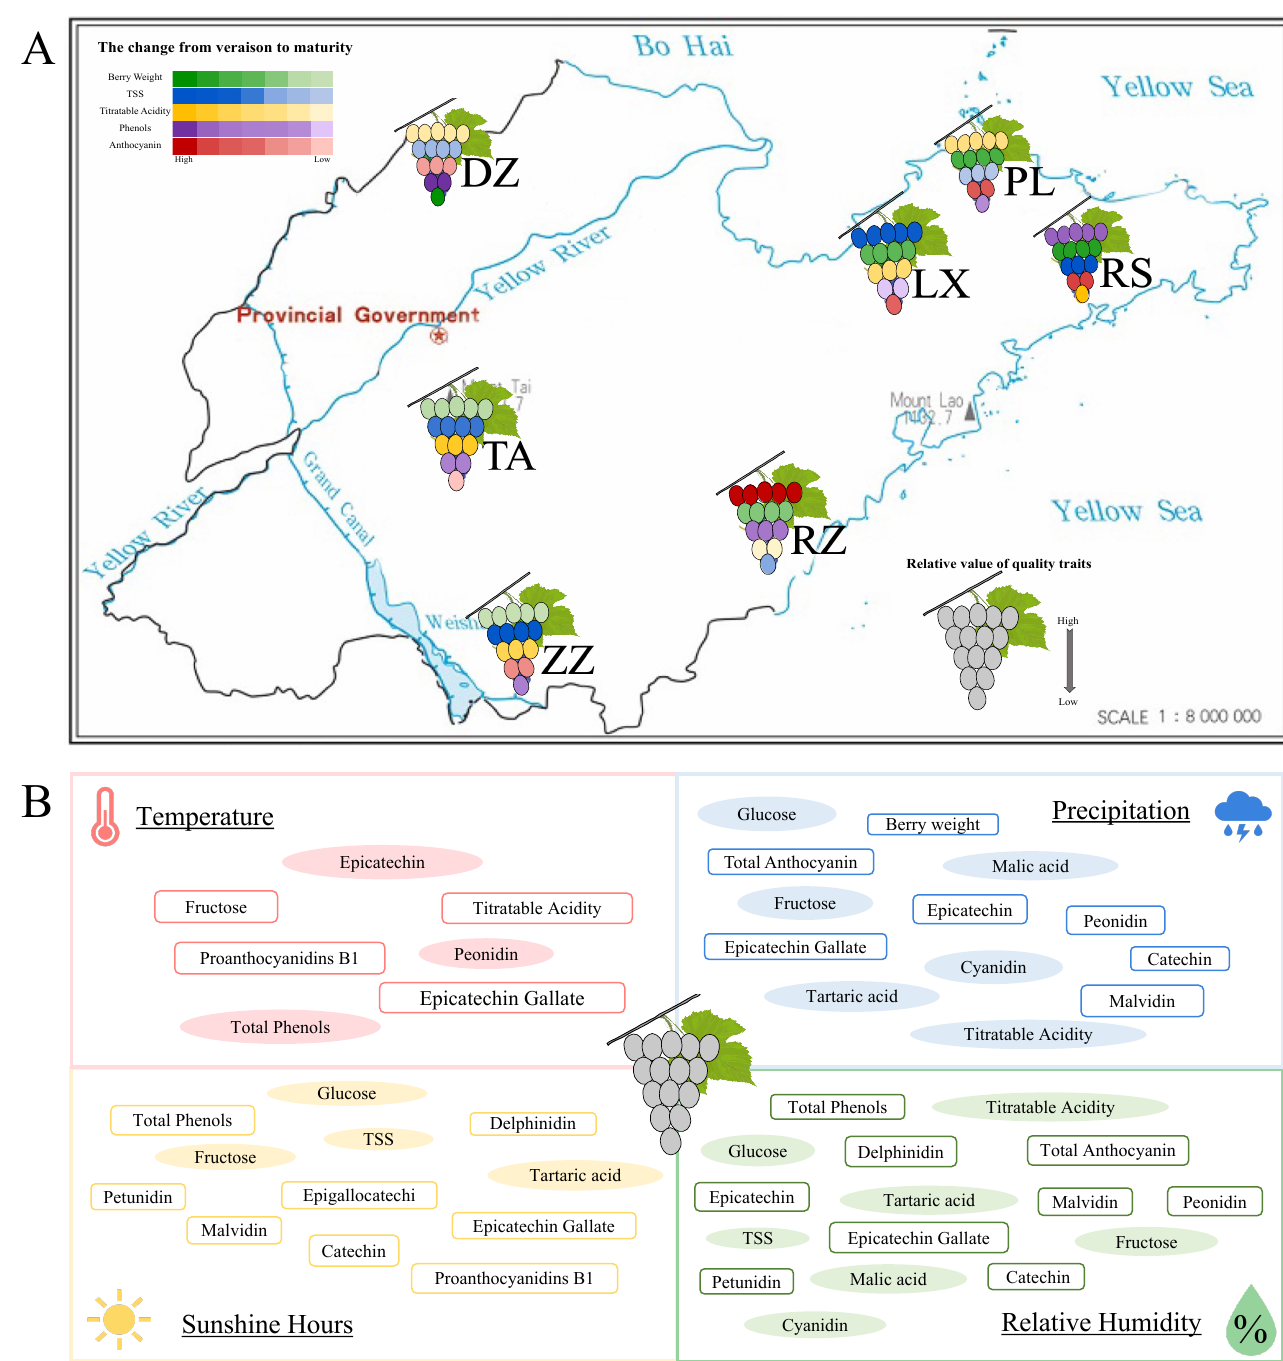
Figure 6. ( A ) Models of berry quality characteristics of ‘Cabernet Sauvignon’ in different regions and their forming from coloration to maturity. Green represents berry weight, blue represents TSS, yellow represents titratable acids, purple represents phenols, and red represents anthocyanins. The shades of color were used to characterize the change from half-v é raison to maturity. The number of berries per color represents the relative value of quality traits. ( B ) Effects of environmental factors on grape quality. Boxes represented grape qualities positively regulated by environmental conditions; ovals represented grape qualities negatively regulated by environmental